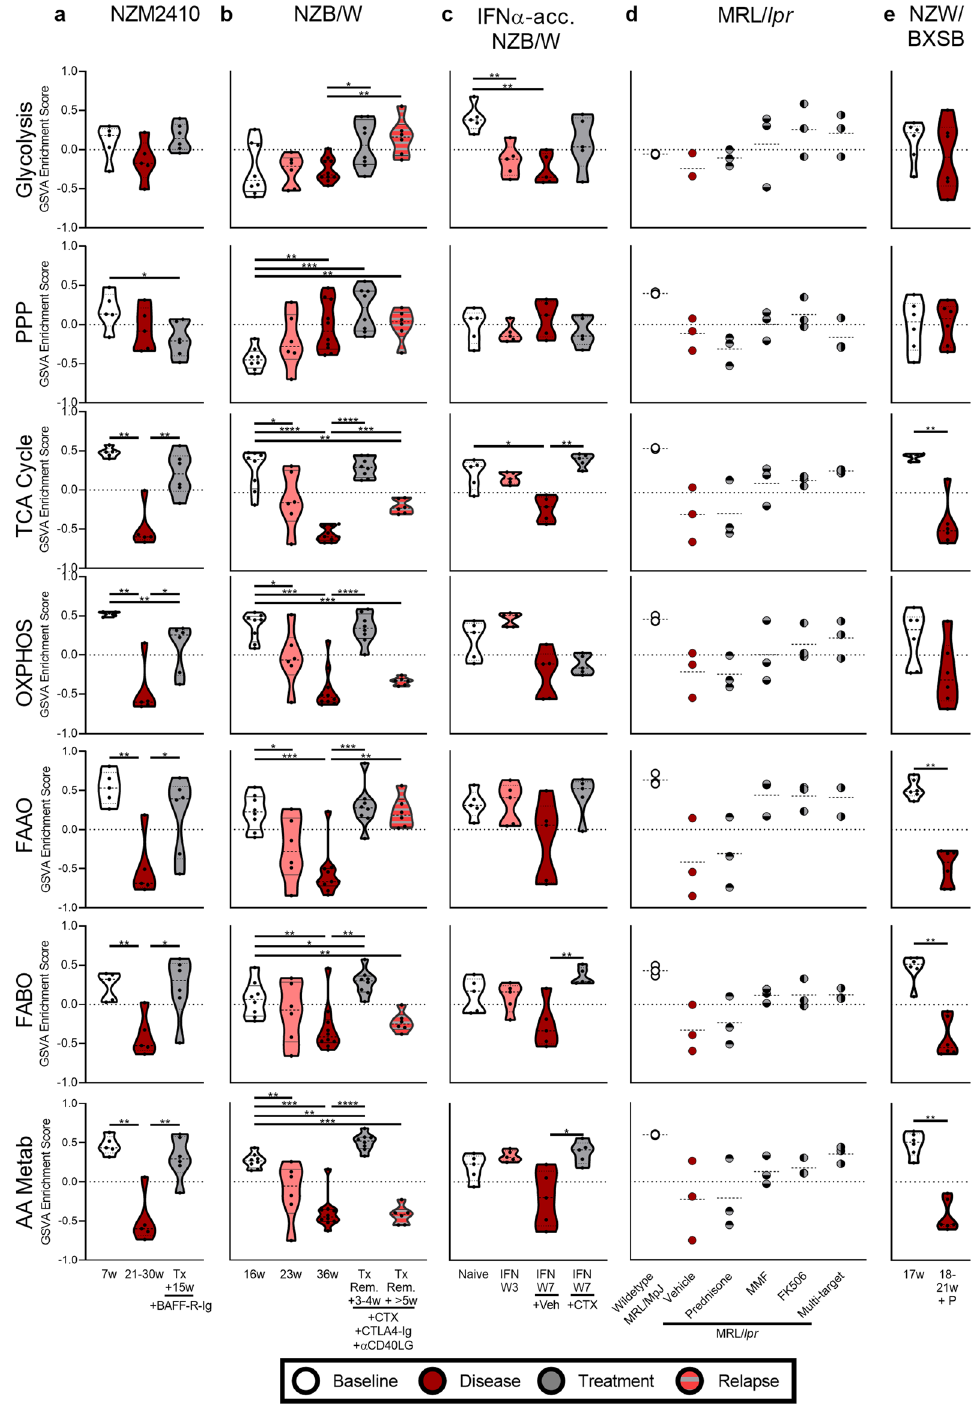
Figure 7. Metabolic gene expression changes in murine LN are corrected with immunosuppressive treatment. GSVA of metabolism signatures in the kidney of ( a ) NZM2410 (GSE32583, GSE49898), ( b ) NZB/W (GSE32583, GSE49898), ( c ) IFNα-accelerated NZB/W (GSE72410), ( d ) MRL/ lpr (GSE153021), and ( e ) NZW/BXSB (GSE32583, GSE49898) mice with and without treatment. Each point represents an individual mouse. For each signature, significant differences in enrichment at each timepoint compared to baseline and each treatment timepoint compared to disease were evaluated with the Mann–Whitney U test. For all calculations the following sample numbers were used: NZM2410 [6w (n = 5), 21-30w (n = 5), Tx + 15w (n = 6)], NZB/W [16w (n = 8), 23w (n = 6), 36w (n = 10), Tx Remission + 3-4w (n = 8), Tx Remission + > 5w (n = 6)], IFN-accelerated NZB/W [Naïve (n = 5), IFN W3 (n = 5), IFN W7 + Veh (n = 5), IFN W7 + CTX (n = 5)], MRL/ lpr [Wildtype (n = 3), Vehicle (n = 3), Prednisone (n = 3), MMF (n = 3), FK506 (n = 3), Multi-target (n = 3)], and NZW/BXSB [17w (n = 6), 18-21w + proteinuria (P) (n = 6)]. *, p < 0.05; **, p < 0.01; ***, p < 0.001; ****, p <